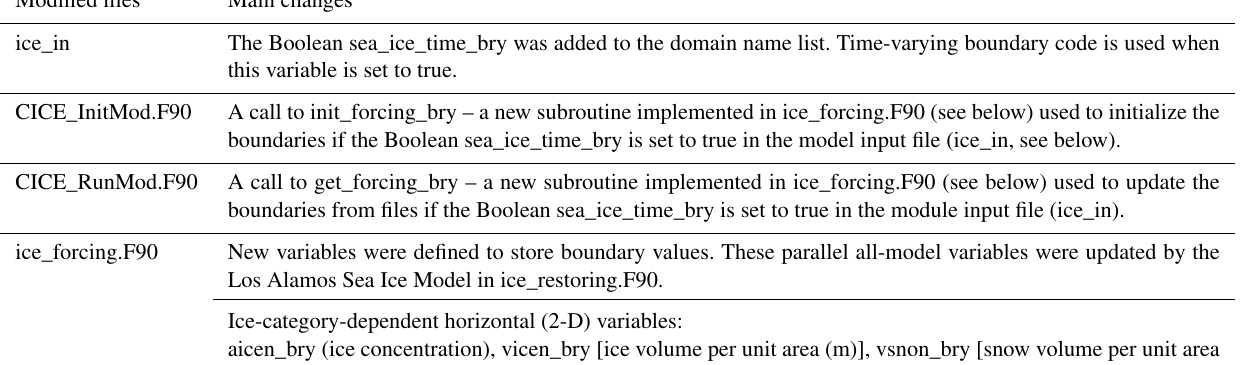
Table 2. Summary of main changes in the Los Alamos Sea Ice Model related to the implementation of time-varying boundaries (https: //doi.org/10.5281/zenodo.5067164 and https://doi.org/10.5281/zenodo.5815093) (see text). Modified